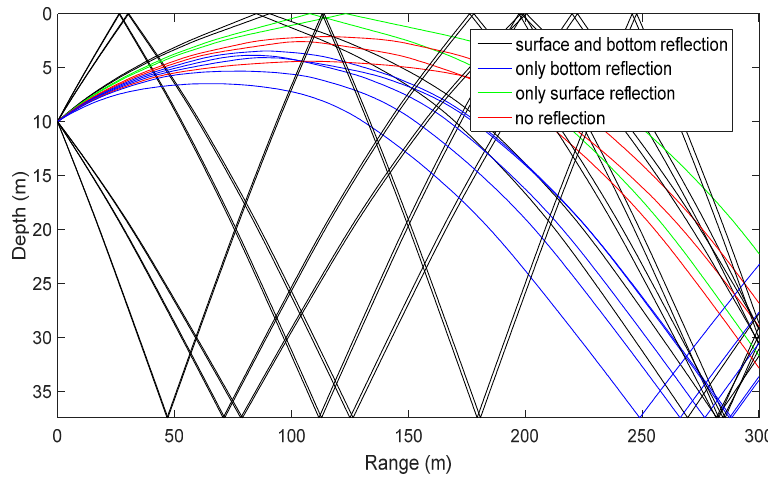
Figure 12. Sound ray transmission path.